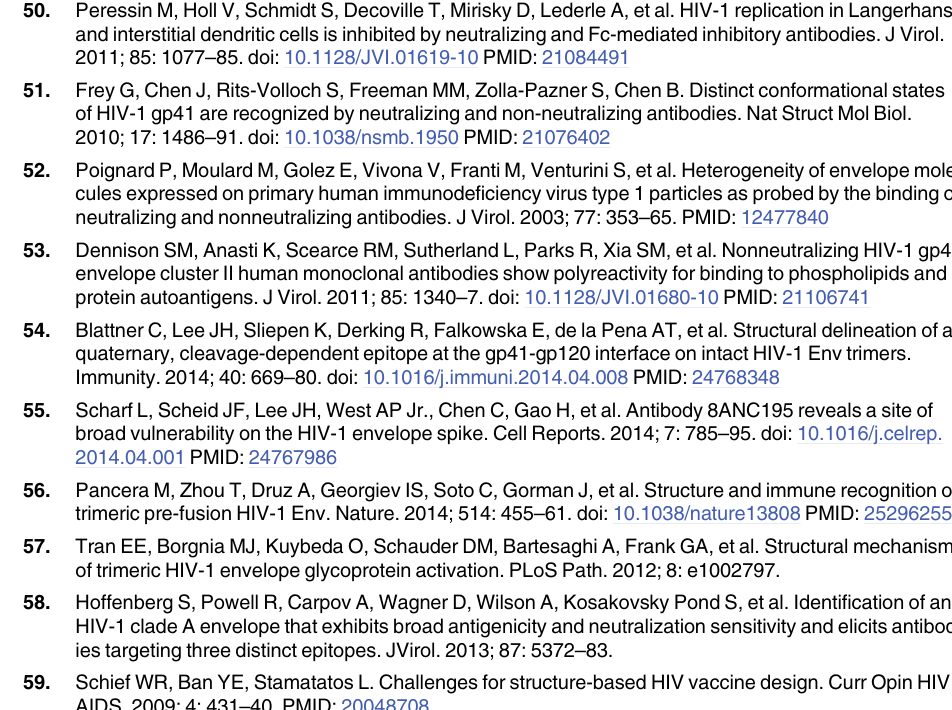
PLOS ONE | DOI:10.1371/journal.pone.0158861 July 13,